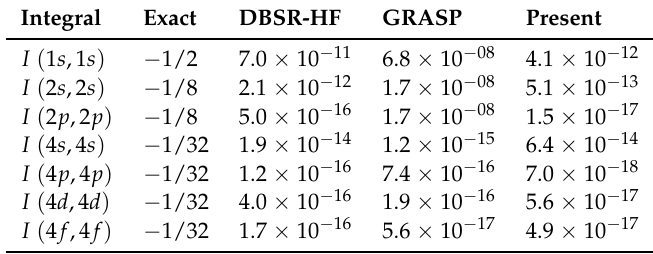
Table 2. The error in I ( a , a ) results for non-relativistic hydrogenic orbitals compared with GRASP and DBSR-HF. All calculations used c = c au × 10 5 as the value for the speed of light. Integral